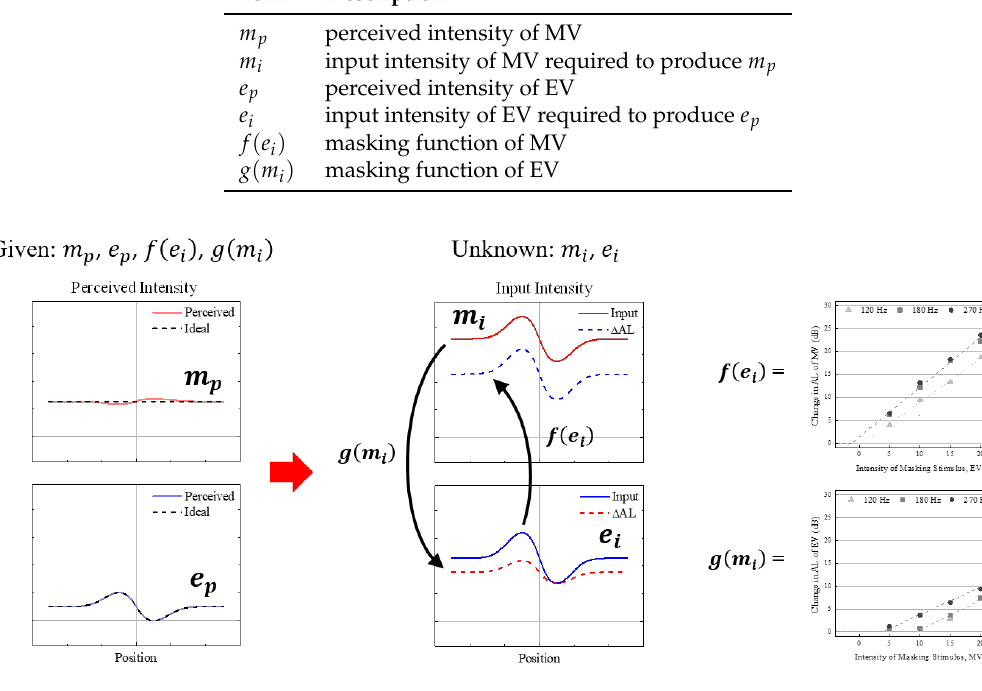
Figure 5. Schematic illustration of the proposed rendering